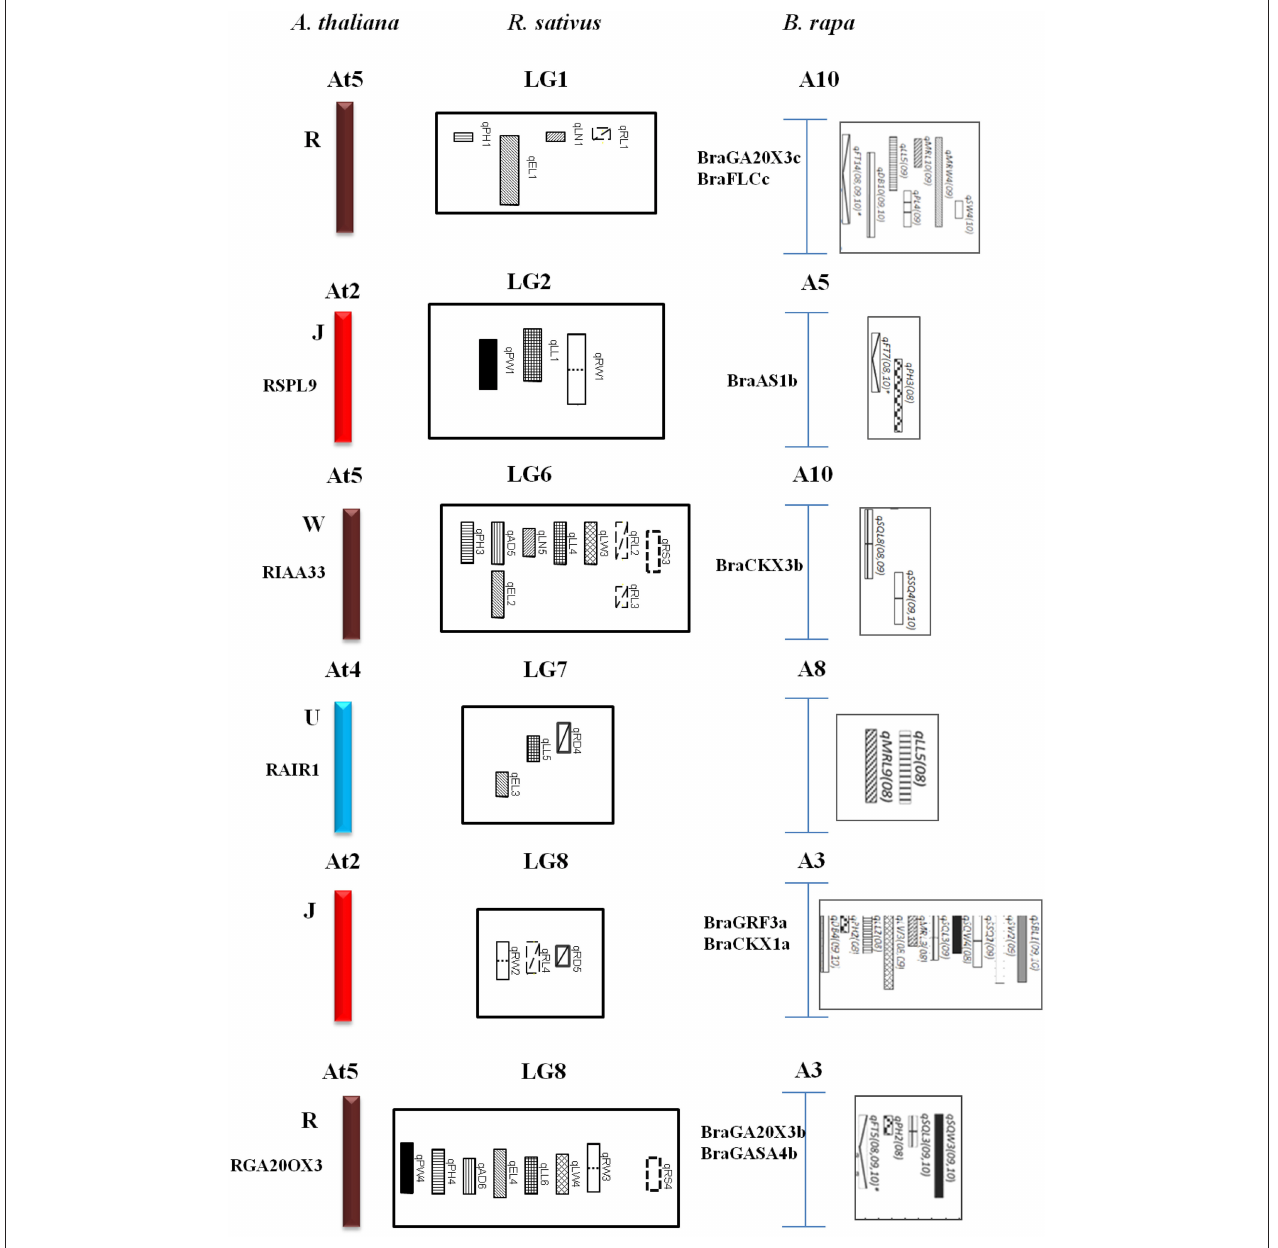
FIGURE 4 | Comparative QTL mapping between radish, A. thaliana and B. rapa revealed conservation of crucifer building blocks governing morphological traits.